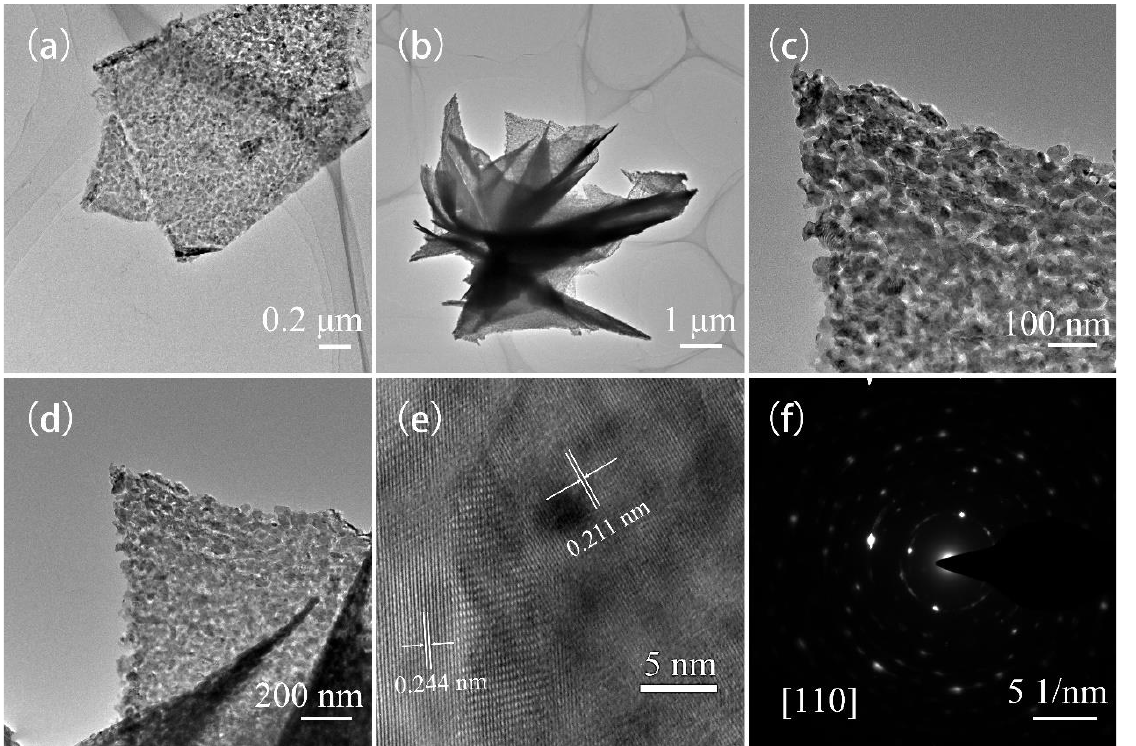
Figure 4. ( a – d ) TEM figures, ( e ) HRTEM figure and ( f ) SAED pattern of CoNiO 2 . Further confirmations of surface elemental composition were done using X-ray pho- toelectron spectroscopy (Figure 5). Figure 5a shows the full scan spectrum of CoNiO 2 , in which Co, Ni and O elements coexist. According to the Co 2p spectra (Figure 5b), the binding energies at 795.0 eV and 779.8 eV correspond to the peaks of Co 2p 1/2 and Co 2p 3/2 , respectively, while the satellite peaks of 803.3 eV and 785.9 eV are associated with its satellites [29]. A correlation was found between Ni 2p 3/2 and Ni 2p 1/2 , as indicated by the characteristic peaks of Ni 2p in Figure 5c located at 854.0 eV and 872.8 eV, and the relevant satellite peaks were also observed at 861.1 eV and 879.5 eV [30]. There are also two characteristic peaks in the O 1s spectrum (Figure 5d); one at 529.6 eV represents oxygen species in the CoNiO 2 phase and the other represents oxygen-containing residuals like H-O-H. Based on the above characterizations, the hierarchical CoNiO 2 microspheres are synthesized